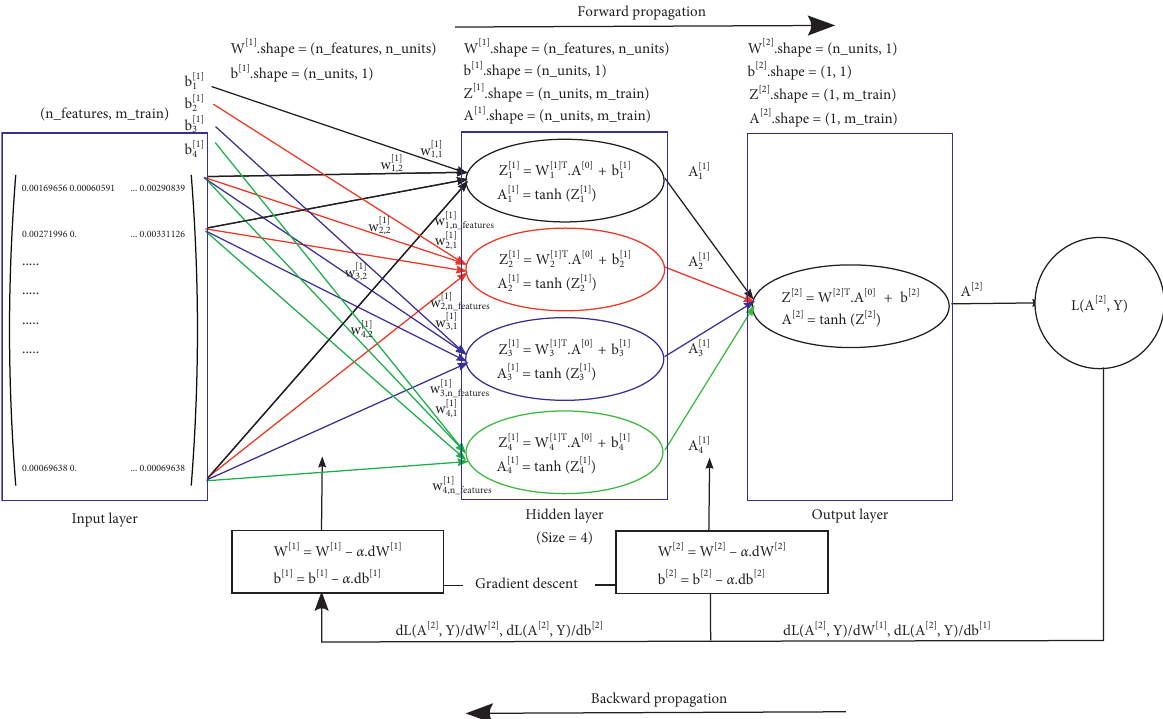
Figure 2: Shallow Neural Network is created when Logistic Regression is applied multiple times. We also show the forward propagation to compute loss and backward propagation to update hyperparameters W [ 1 ] , W [ 2 ] , b [ 1 ] , and b [ 2 ] . The forward propagation and backward propagation are performed for a number of iterations, until we reach to the global minima of the sum of cross-entropy loss for all features.